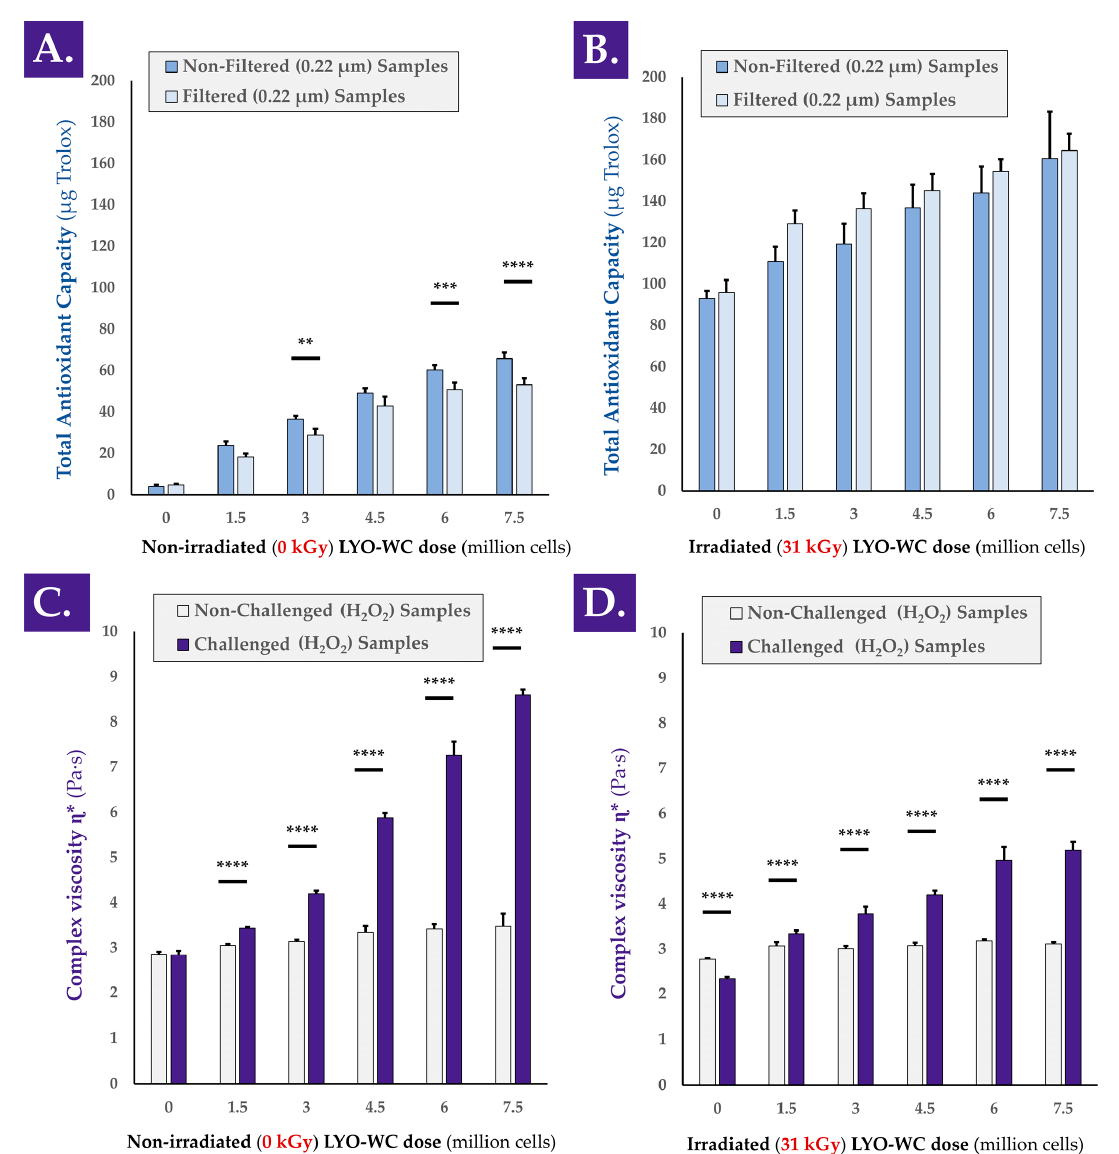
Figure 1. Comparative assessment of the TEAC values and hydrogel viscosity modulating properties of various doses of progenitor tenocyte whole cell samples (i.e., lyophilizates reconstituted in aqueous solvent), before and after submicron filtration and γ -irradiation, respectively. TEAC dose-response of reconstituted non-irradiated ( A ) or γ -irradiated (31 kGy, ( B )) whole cell samples containing 1.5 to 7.5 million cell equivalents/vial before and after 0.22 µ m filtration, with the corresponding placebo controls. Results notably outlined a strong response (i.e., relative increase) of the γ -irradiated samples in TEAC measurements compared respectively to the same non-irradiated samples (( B ) vs. ( A )). Complex viscosity η * of reconstituted (i.e., in a hydrogel of HA 2.2–2.4 MDa MW at 1% in H 2 O:PBS 1:1) non-irradiated ( C ) or γ -irradiated (31 kGy, ( D )) whole cell samples containing 1.5 to 7.5 million cell equivalents/vial, with the corresponding placebo controls. Each sample was analyzed following the addition of H 2 O 2 (i.e., challenge item) or PBS (i.e., internal non-challenged controls) and incubation for 1 h at 37 ◦ C. Very significant statistical differences (i.e., ** or 0.001 < p value < 0.01) or extremely significant statistical differences (i.e., *** or 0.0001 < p value < 0.001; **** or p value < 0.0001) were found between the presented mean values. HA, hyaluronic acid; kGy, kiloGray; LYO-WC, lyophilized whole cell fraction; MW, molecular weight; PBS, phosphate buffered saline; TEAC, Trolox equivalent antioxidant